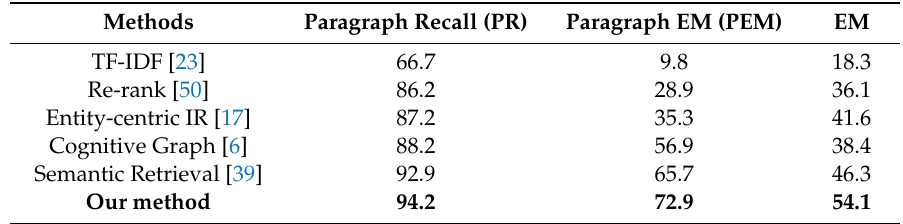
Table 3. Retrieval evaluation: Comparing our retrieval method with other methods across Paragraph Recall, Paragraph EM, and EM metrics. The highest value per column is marked in bold.